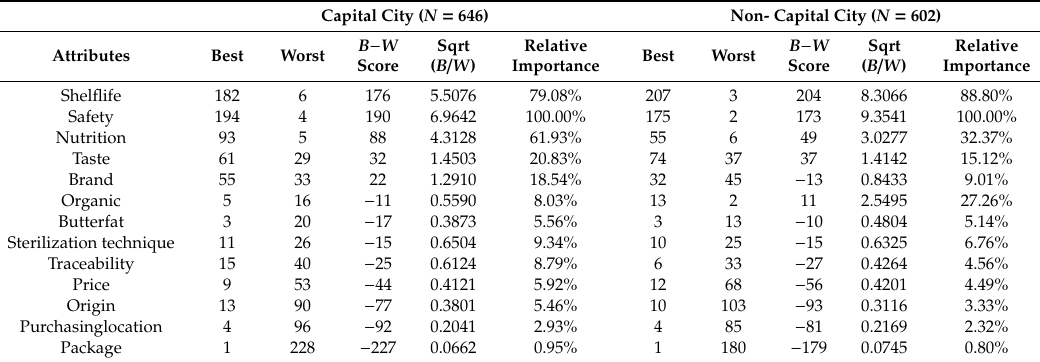
Table A1. BWS Scores in both capital cities and non-capital